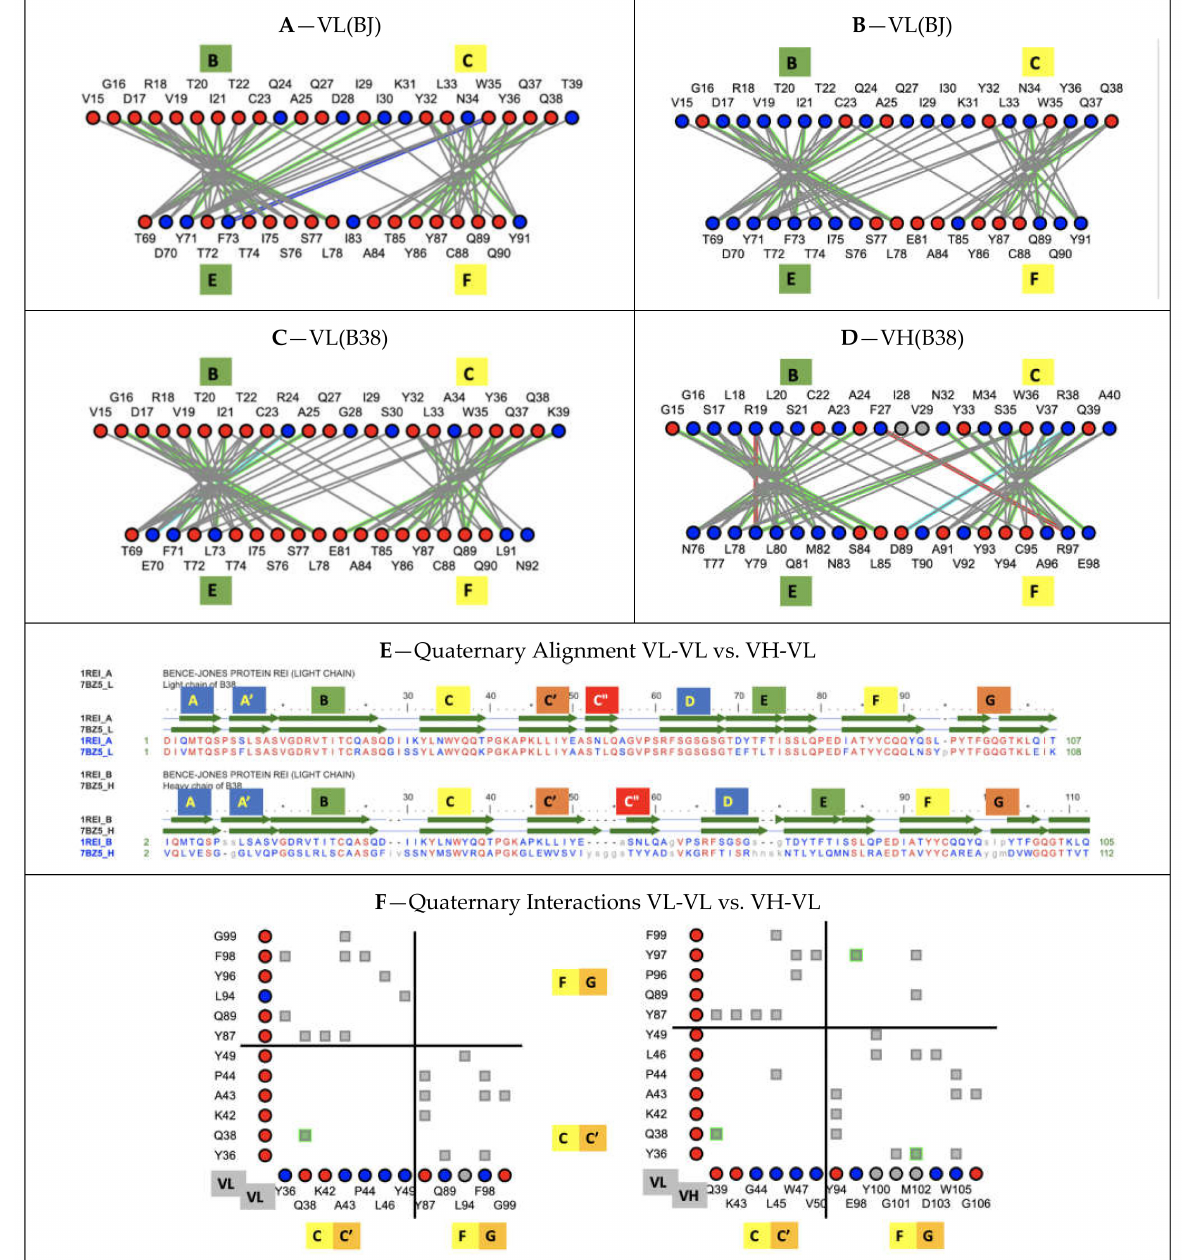
Figure 7. Interaction networks at the Ig protodomain core interface and quaternary Ig-Ig interface. Comparing protodomain interface BC/EF for ( A ) B38 Antibody VL domain (7BZ5) ( B ) B38 Antibody VH domain ( C ) Bence Jones (BJ) VL domain chainA (1REI) ( D ) Bence Jones (BJ) VL domain chainB (https://structure.ncbi.nlm.nih.gov/icn3d/share.html?i2HiYhm3 e4P8ecby6, accessed on 27 August 2021)—residue node colors: red = conserved/blue = not conserved between antibody VH-VL B38 and Bence Jones protein dimer VL-VL. Line colors: interactions: grey = VdW contact; green = H-bond; cyan = charge–charge; red = charge–aromatic; blue = charge–aromatic. Cys bonds shown in grey. The interface exhibits a conserved pattern, including, in particular, the CCW residues. ( E ) Quaternary Alignment BJ VL-VL vs. B38 VH-VL: the VH-VL dimer (7BZ5) aligns with a VL-VL dimer (1REI) within 1.53 A RMSD over 202 residues with 57% sequence identity. ( F ) Quaternary interface of BJ homodimer VL-VL (left) vs. B38 heterodimer VH-VL (right) with contributions from protodomain 1 (CC’) and protodomain 2 (FG), forming the GFCC’ sheet (https://structure.ncbi.nlm.nih.gov/icn3d/share. html?aYHnSxgAD6kSoQqn8, accessed on 27 August 2021)—colors as in ( E )—notice the symmetry in contacts in VL-VL (apart from a small experimental difference) vs. asymmetry in VH-VL, with a highly conserved Q38 vs. Q38/39 H-bonded interaction